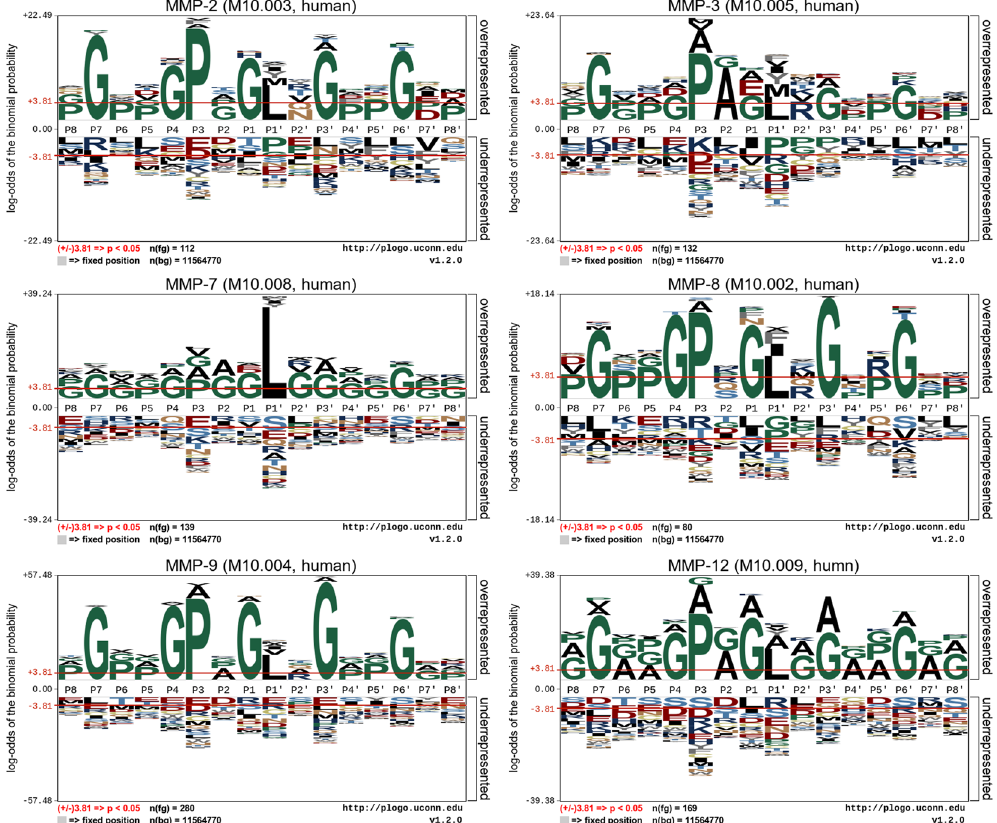
Figure 1. Sequence-logo representations of the occurrences of amino acid residues surrounding the substrate- cleavage sites (from P8 to P8 ′ positions) of MMP-2, -3, -7, -8, -9, and -12. Sequence logos were generated using the pLogo program 78 . The red horizontal lines on the pLogo plots denote the statistical significance threshold ( p =